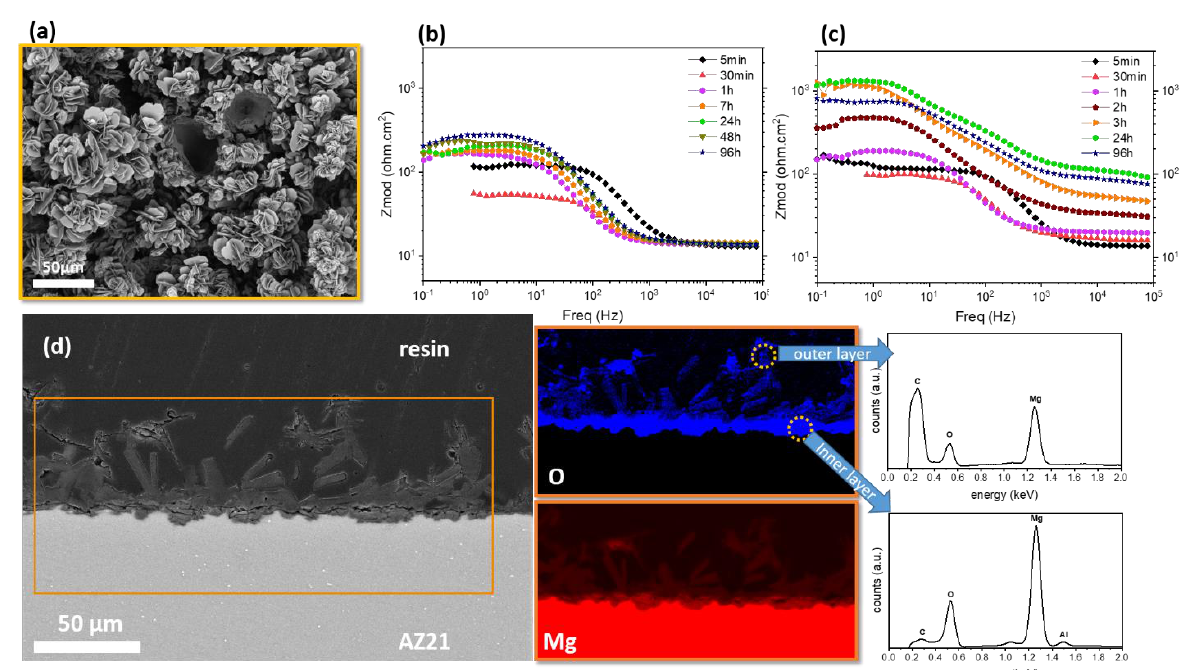
Figure 7. ( a ) Surface morphology of bare AZ21 exposed to 3.5 wt.% NaCl electrolyte containing 8HQ. ( b , c ) Bode plots of the EIS spectra obtained for the AZ21 Mg during 4 days of immersion in NaCl 3.5 wt.% solution with and without 8HQ, respectively. ( d ) Cross section view of ( a ) along with the elemental mappings of the marked area. Adapted from [102] with permission from Elsevier.